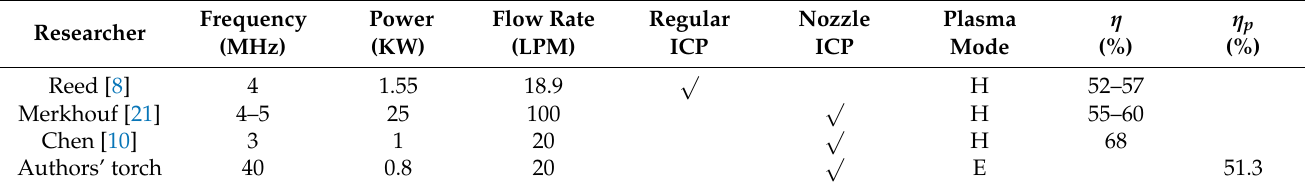
Table 3. Torch efficiency in literature (atmospheric pressure, gas: